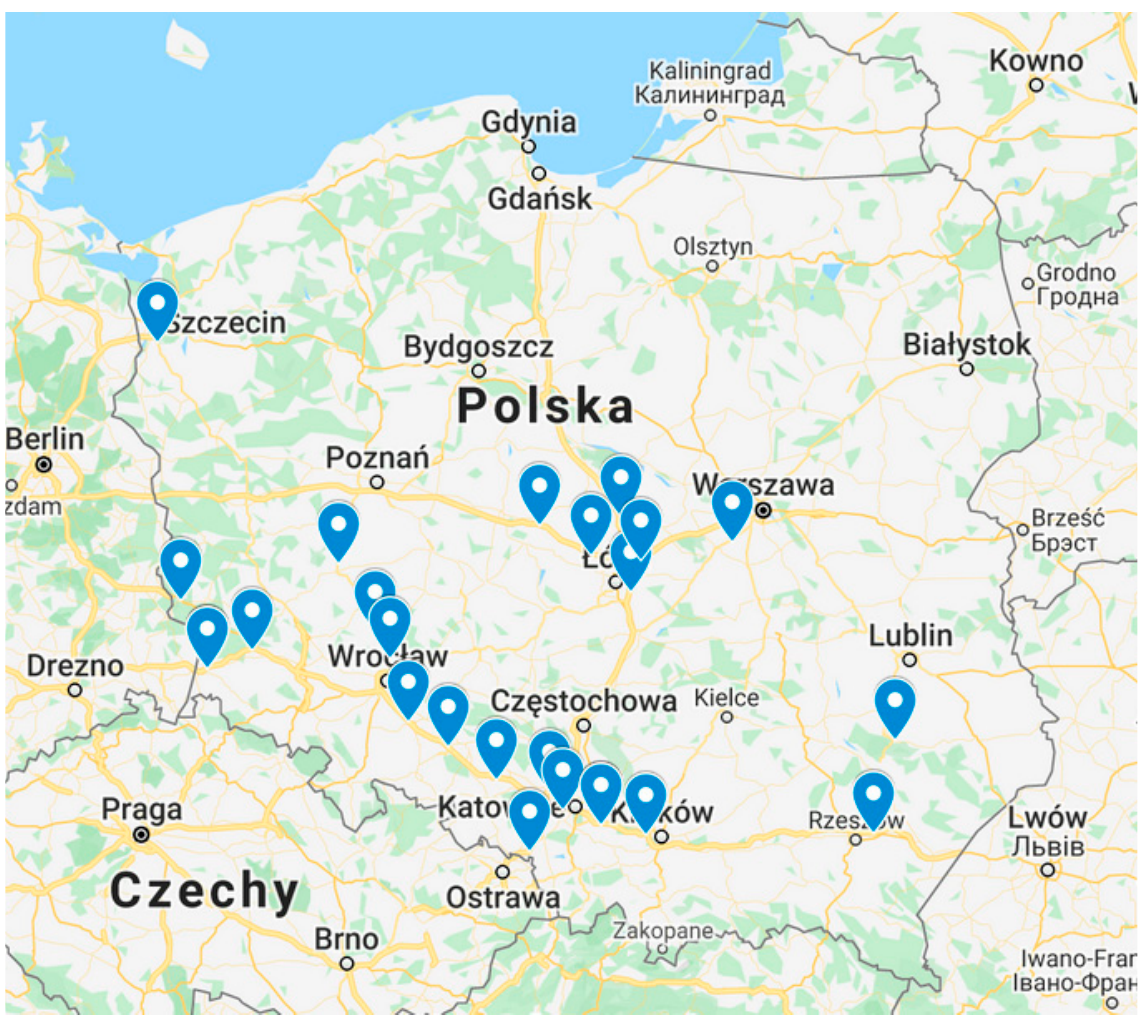
Figure 8. Proposal of ideal locations of RSAs equipped with sheds along the motorways and expressways in Poland.